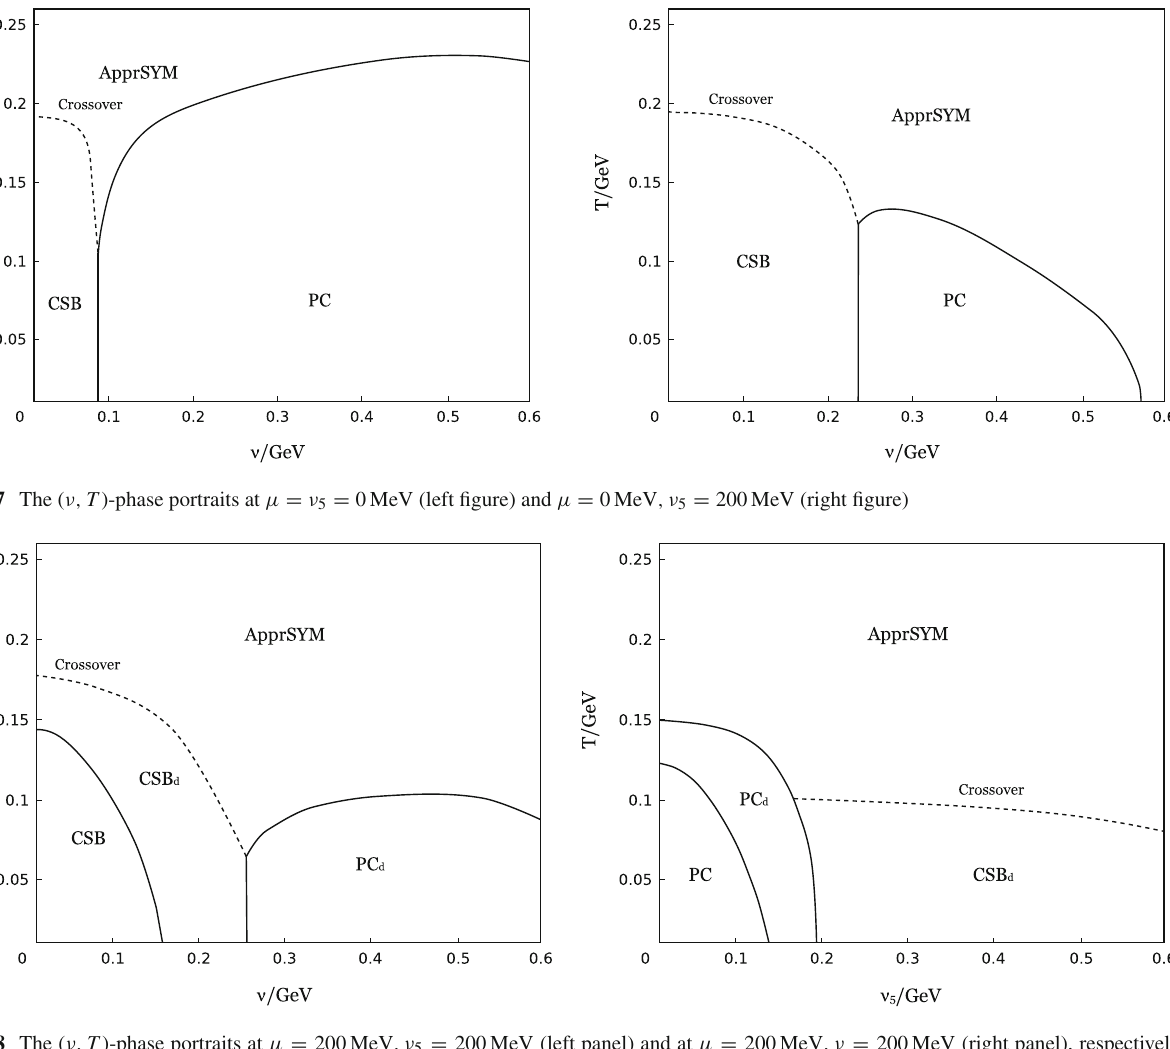
presence in the NJL model (5) at m 0 (cid:2)= 0 of an